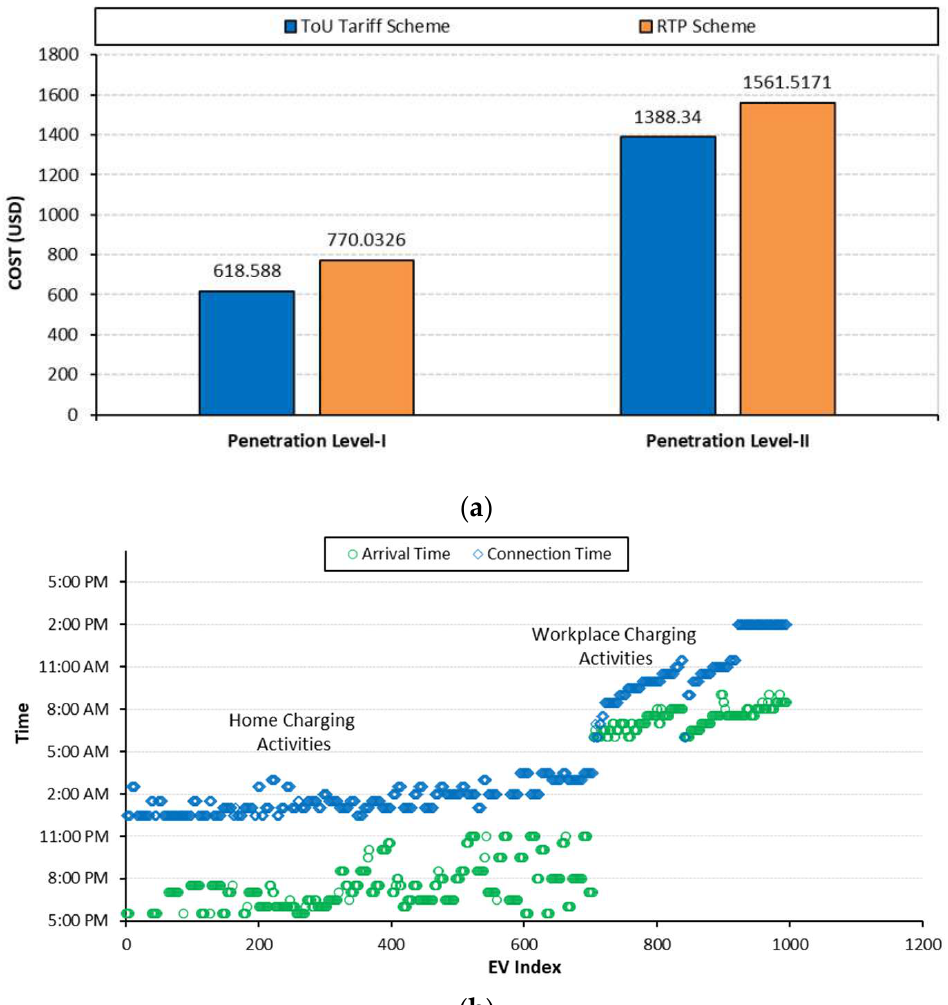
Figure 13. Case C: ( a ) Charging cost; ( b ) waiting time .